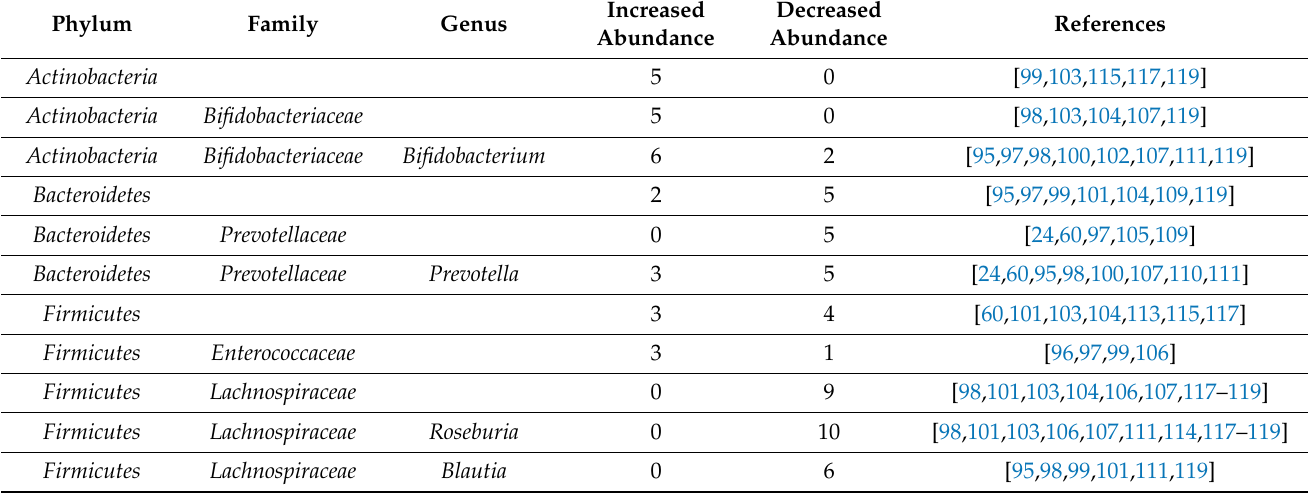
Table 1. Different abundant taxa between Parkinson’s disease (PD) patients and healthy controls